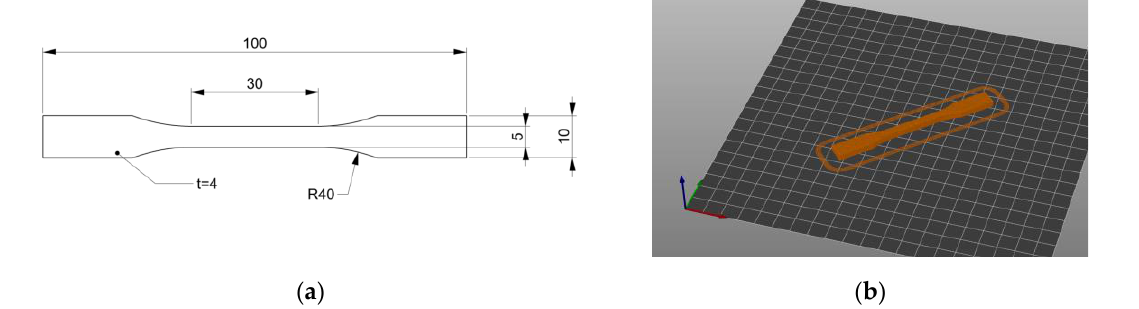
Figure 7. Tensile specimen, 1BA type, according to ISO 527 standard: ( a ) dimensions and ( b ) manufacturing orientation with respect to the building plate.